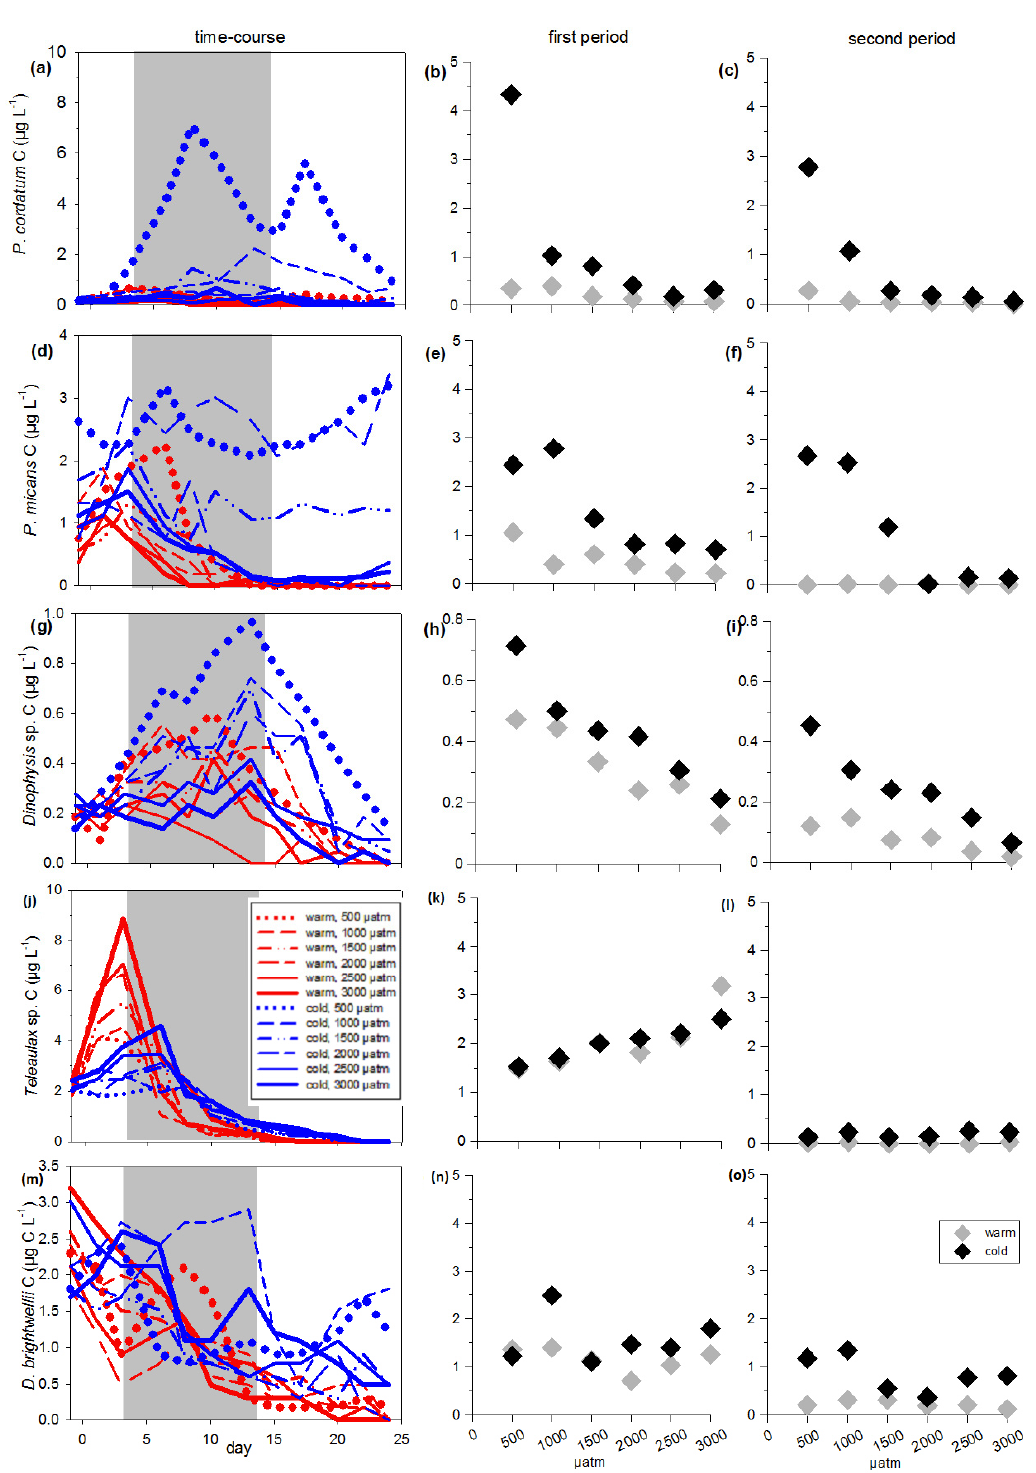
Figure 3. Carbon ( µ g C L − 1 ) of the inedible and edible phytoplankton groups over the entire course of time and as mean values of the first and the second period. The first period, during which a bloom in the warm treatments occurred, is marked in grey color in the subpanels ( a , d , g , j , m ). Inedible phytoplankton groups: ( a – c ) flagellates >100 µ m C, ( d – f ) filamentous Symbol attribution to treatment combinations (temperature treatments + CO 2 target values) are given in the legend. Fitted lines indicate a significant response of phytoplankton relative contribution to CO 2 at the different temperature